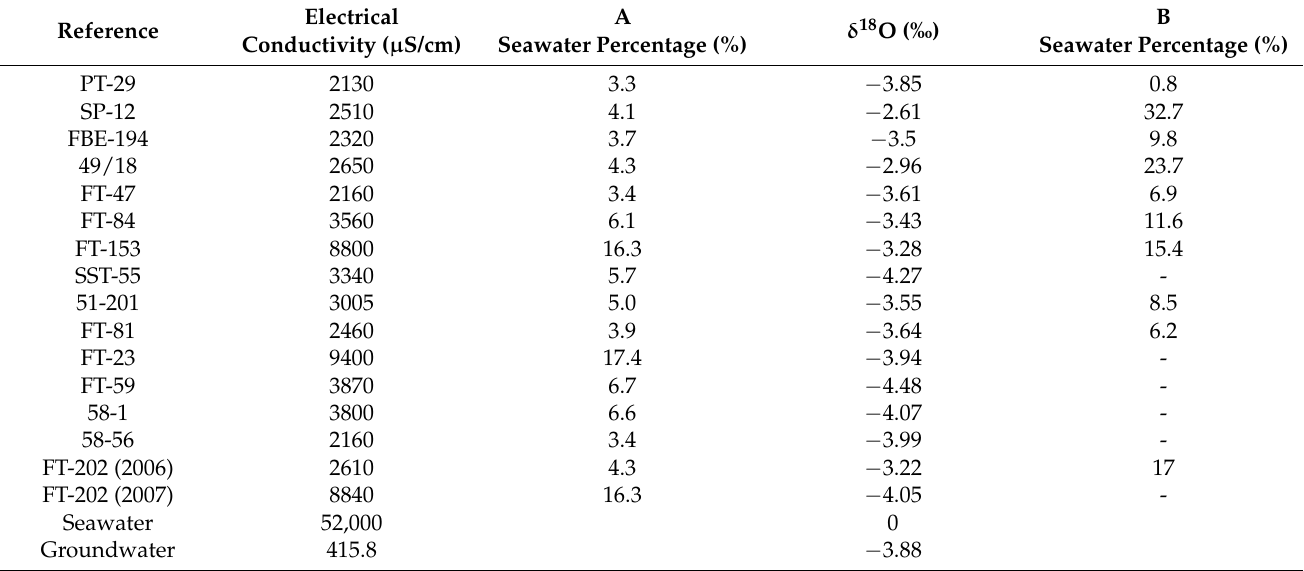
Table 1. Percentage of seawater in the groundwater samples. The data represent the amount of seawater estimated in percentage using the different tracers A—Electrical Conductivity and B— 18 O content (data from 2005 and 2006 sampling